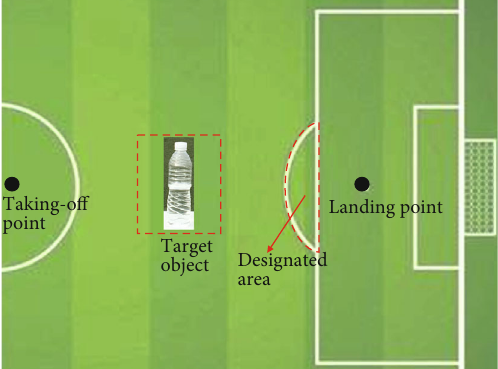
Figure 10: Sketch of experiment